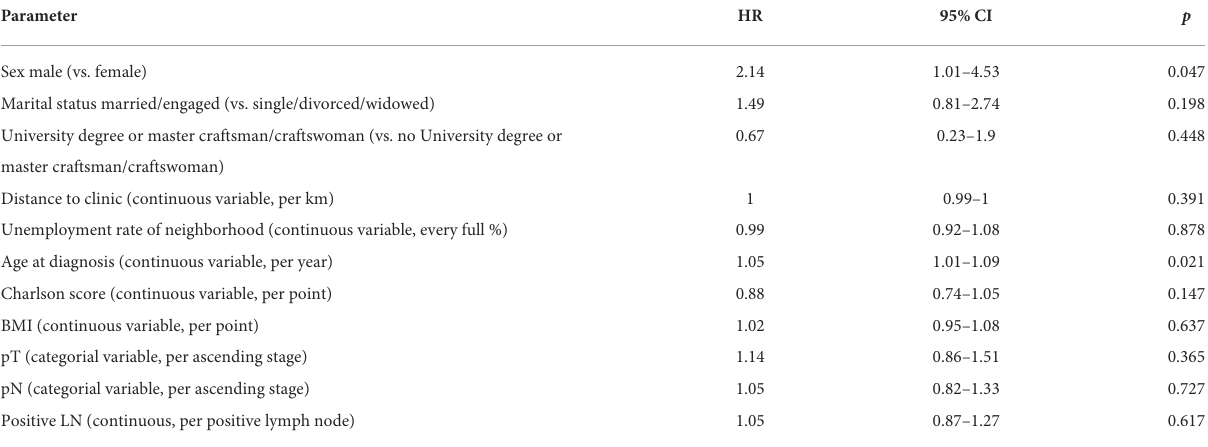
TABLE 6 Cox proportional hazard model for recurrence-free